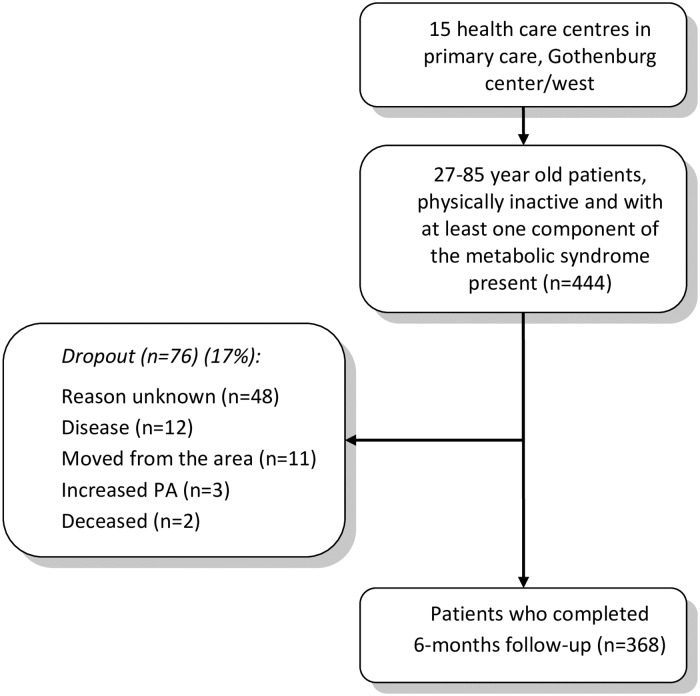
Flow of patients involved in the study.The patients were recruited from 15 health care centers.